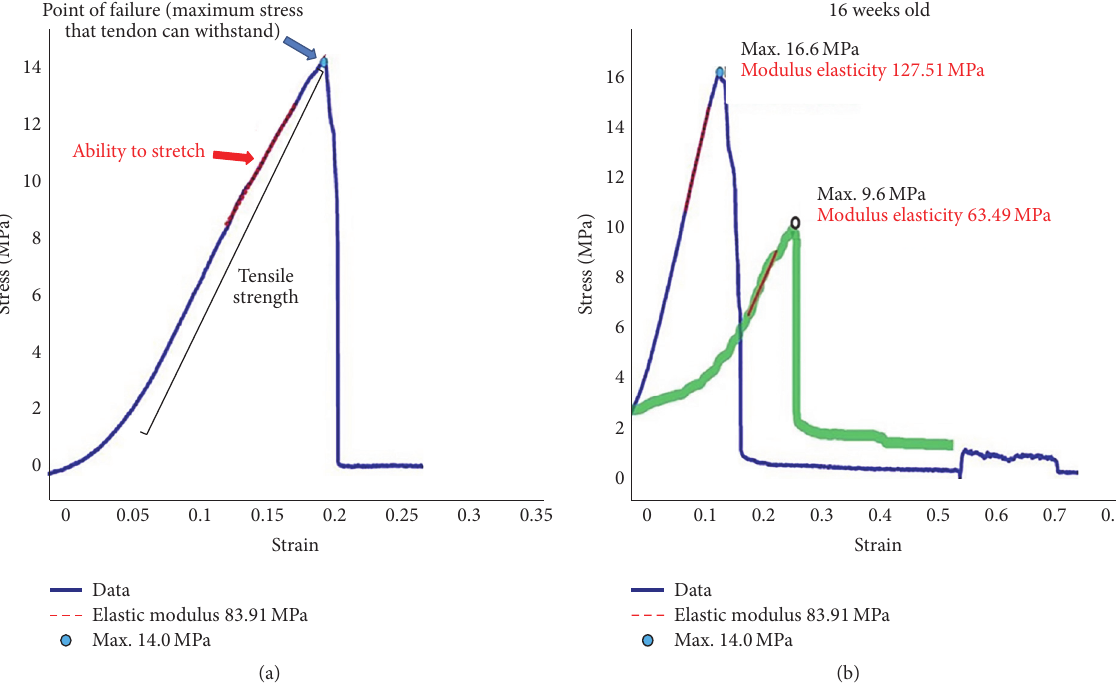
Figure 3: Stress/strain curves. (a) Stress/strain curve in 16-week-old turkey. (b) Stress/strain curves of median infected versus noninfected control (16 weeks of age): the blue curve with higher peak of stress refers to the median value of tensile stress in control birds and the green curve with lower peak of stress refers to the median value of tensile strength in infected birds. Unit of measurement in megapascals